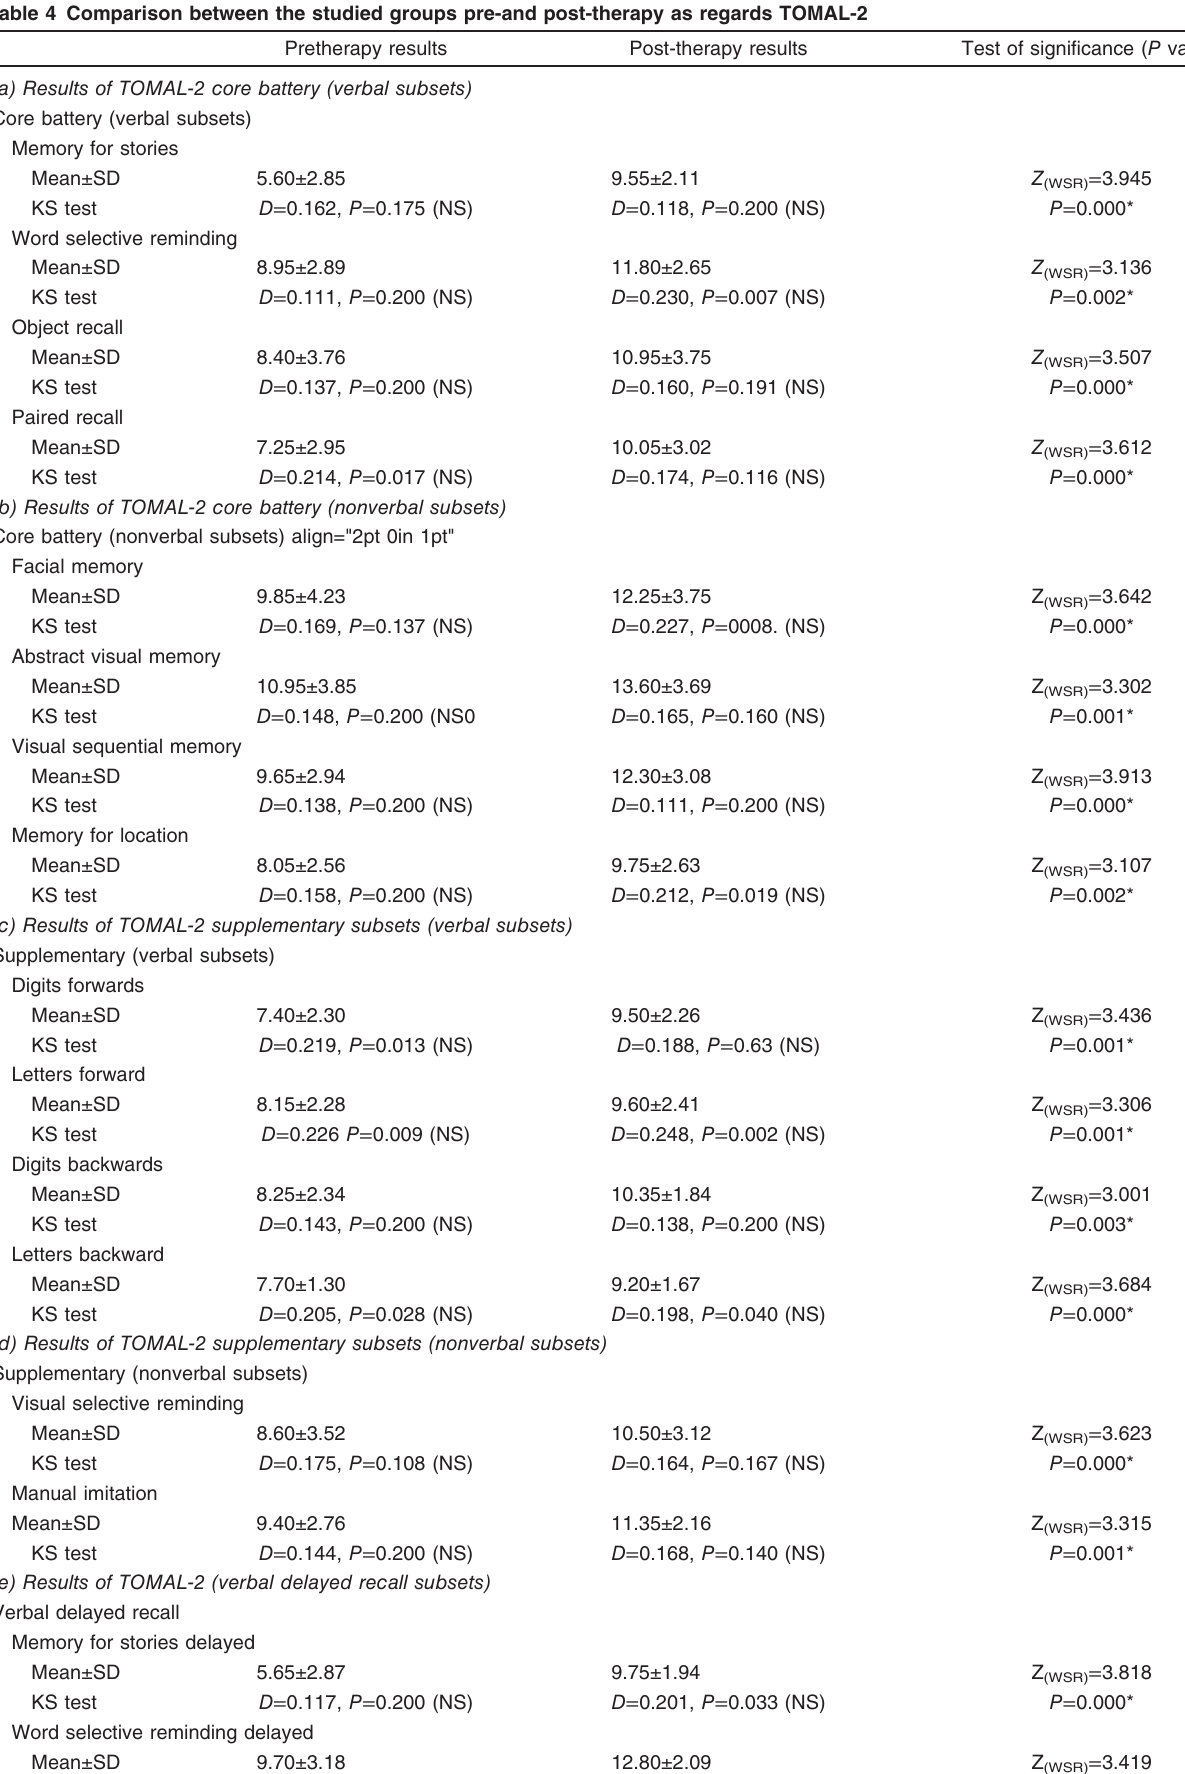
Table 4 Comparison between the studied groups pre-and post-therapy as regards